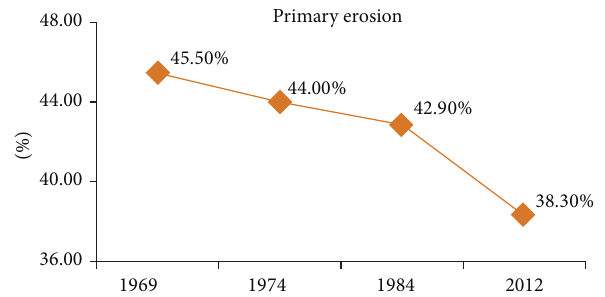
Figure 6: Primary erosion in the period from 1969 to 2012 for two types of land: agroforestry and the land mainly occupied with agriculture, derived from topographic maps (TK 1:25,000, section (582 Nis: 1-4, 3-2, 1-3, 3-1, 3-3, and 3-4, 581 Kursumlija: 4-1, 2-4, 4- 2, 4-4) and from Land Cover Map obtained by using CORINE-like approach in 2012.